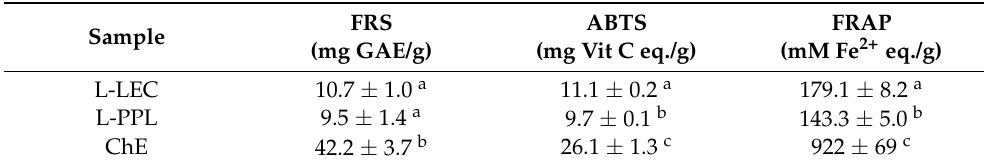
Table 2. Antioxidant activity (ABTS and FRAP assays) and Folin-reactive substances (FRS) of chia extract (ChE) and liposomes made of commercial rapeseed lecithin (L-LEC) and partially purified phospholipid fraction (L-PPL), both loaded with the chia extract.